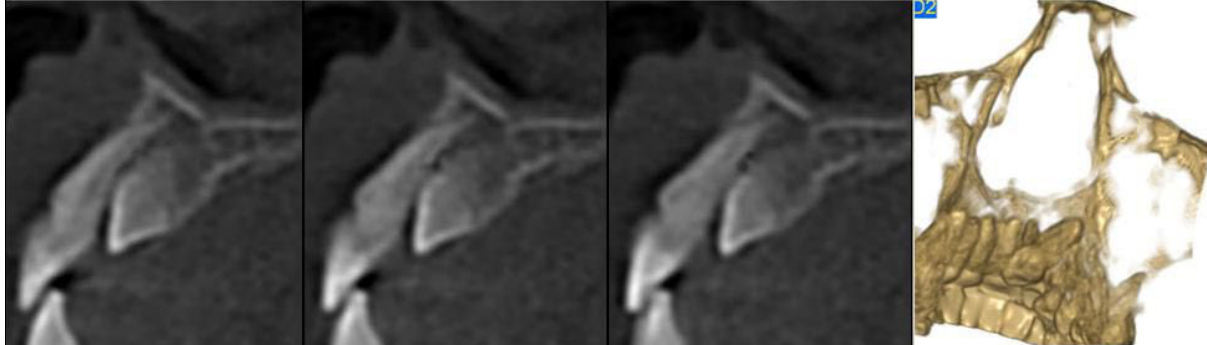
Figure 4. 3D CBCT image with sagittal slices showing the location of the transmigrated maxillary canine in